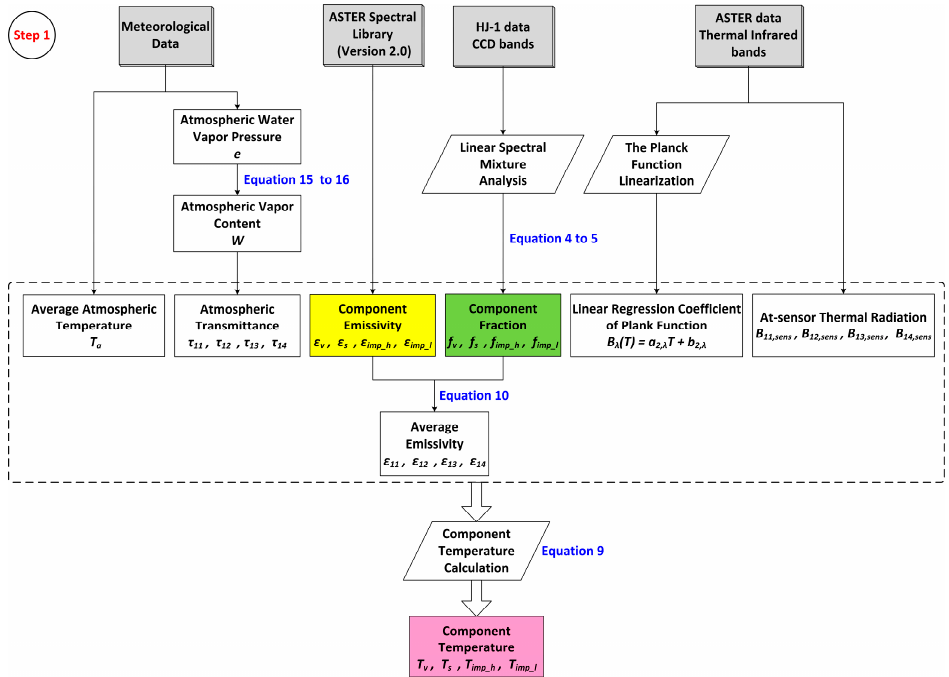
Figure 3. Flowchart of the first step (Step 1) of our model, as detailed in Sections 3.1 and 3.2. The gray rectangles represent the input data, and the other color rectangles indicate the parameters that were used more than once in the next steps. Equations used in each of the processes are highlighted in blue. Full forms of the variables in the flowcharts are listed in Table A1 in the Appendix.